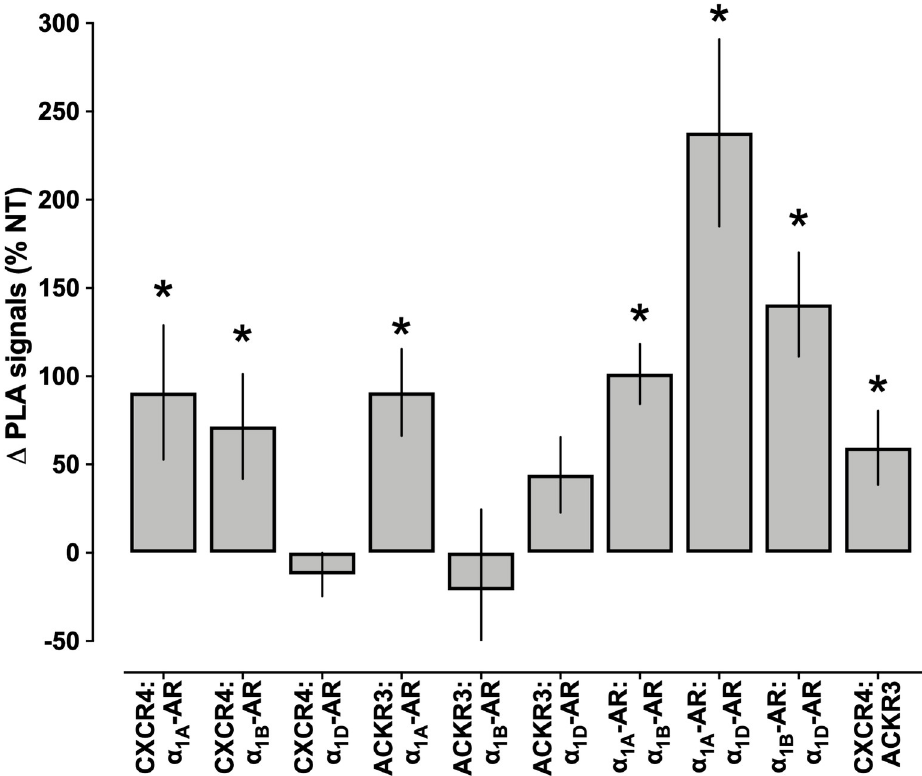
Fig 9. Re-organization of heteromers between α 1A/B/D -ARs, CXCR4, and ACKR3 upon depletion of AVPR1A in hVSMCs. Quantification of PLA signals for the detection of receptor-receptor interactions in hVSMCs